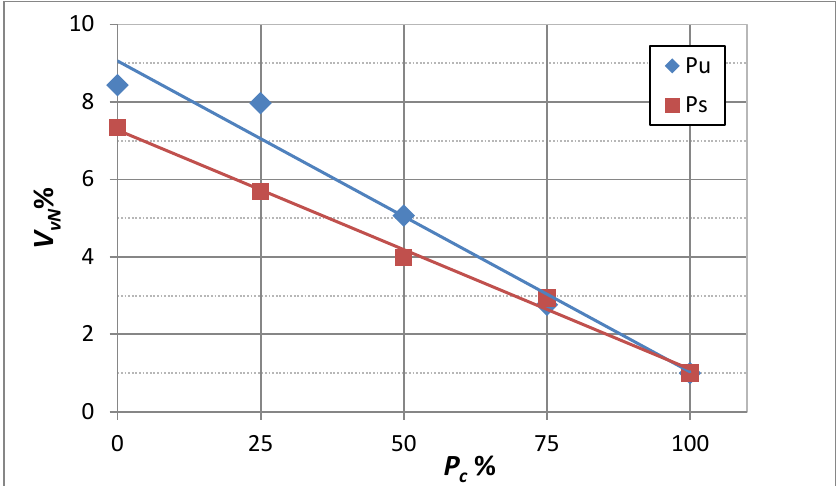
Figure 3. Normalized volume fraction of voids, V Pu and Ps